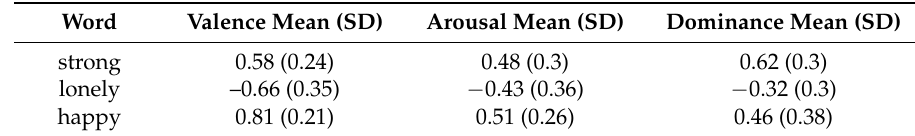
Table 1. Sample annotations of words from Russel and Mehrabian lexicon.